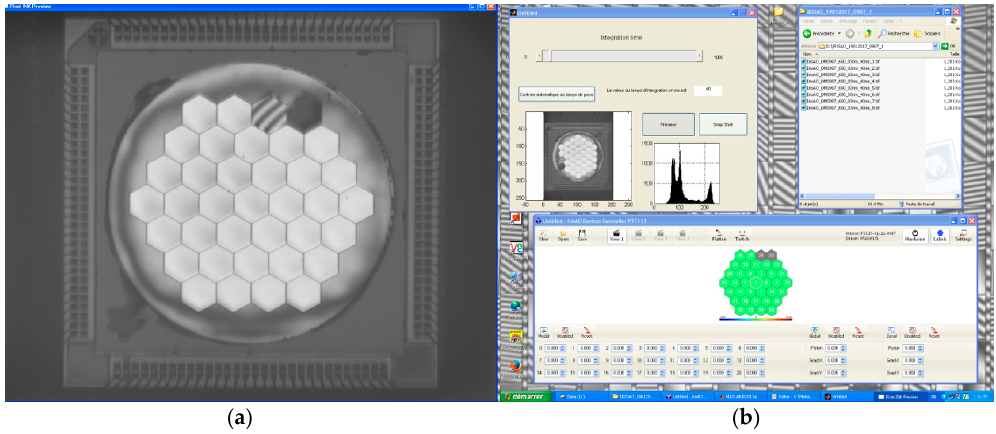
Figure 7. Screen shot during the experiment; ( a ) The interferometric image of the mirror when the “best flat” condition is applied; ( b ) The Iris AO GUI for driving the device.